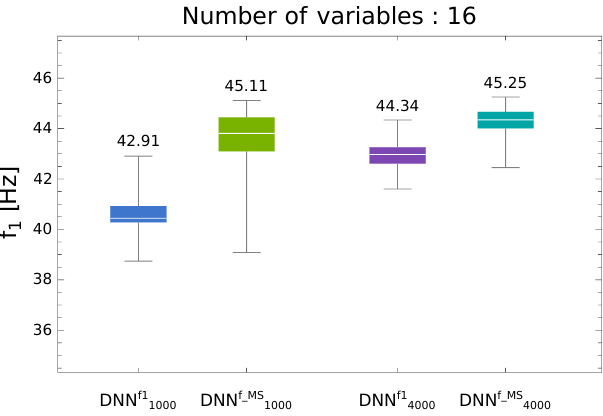
Figure 2. Theaccuracyof f 1 maximizationusingeither f MS = DNN f 1 ( Λ ) or f MS = DNN f MS ( Λ ) metamodels.